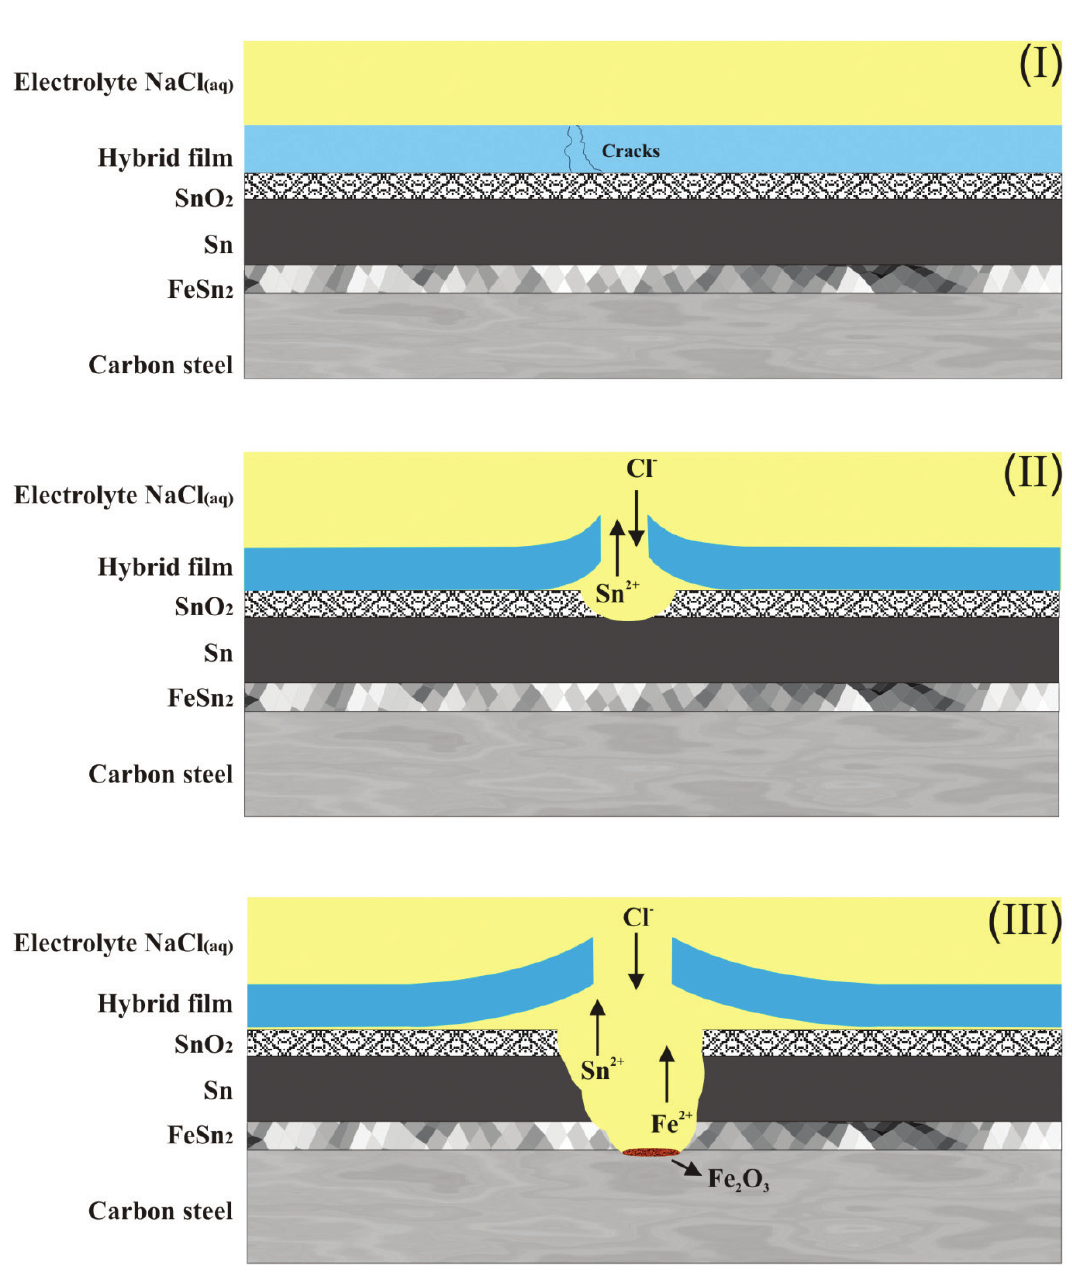
Figure 11. Corrosion mechanism for hybrid film with acid hydrochloric in the electrolyte NaCl